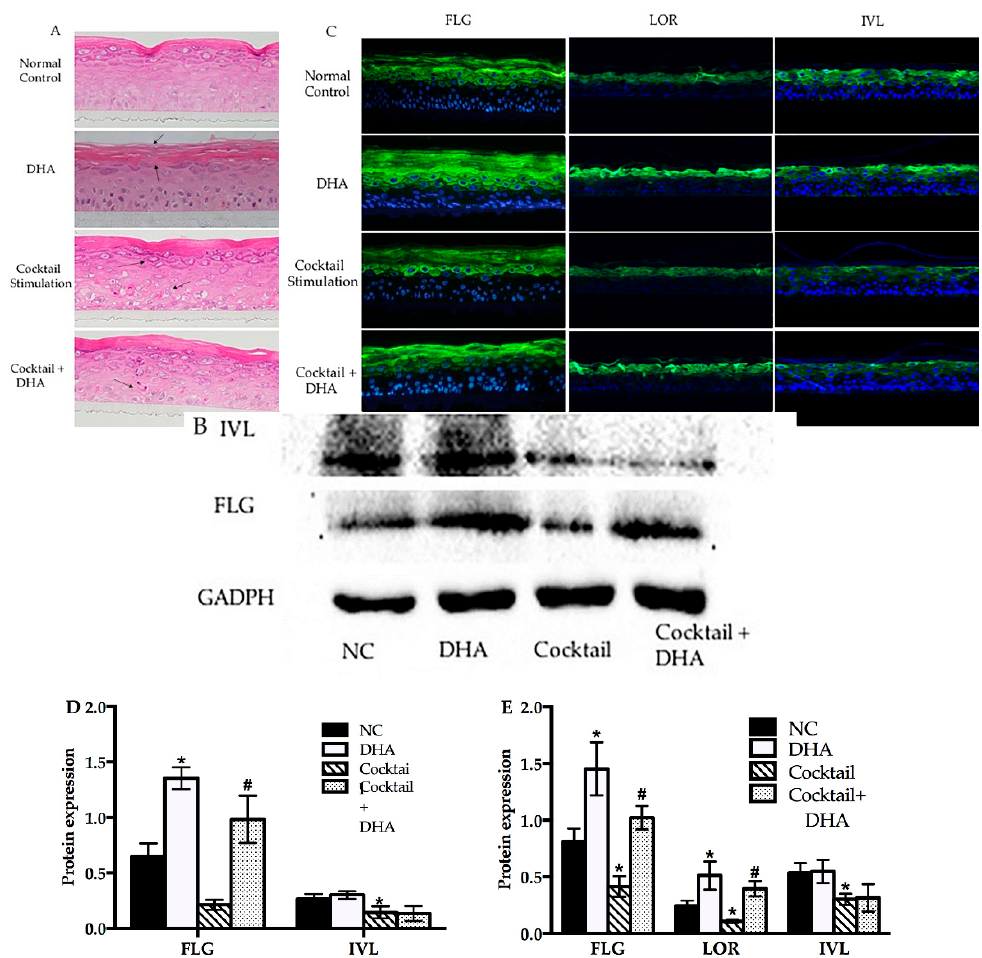
Figure 4. Topical treatment with DHA affected the morphology and differentiation protein expression in normal and inflammatory RHE models. ( A ) Morphology of normal, DHA cocktail-induced, and DHA-treated groups were evaluated using hematoxylin–eosin (HE) staining. ( B ) Western blot of FLG and IVL in normal control, DHA cocktail-induced, and DHA-treated groups. ( C ) Immunohistofluorescence analysis was executed for FLG, LOR, and IVL in the above RHE models. ( D ) Relative optical densities of FLG and IVL. ( E ) Relative fluorescence densities of FLG, IVL, and LOR. Magnification 10×, mean ± SD, n = 4–5. * Compared with the blank control groups, p < 0.05; # compared with the inflammatory group, p < 0.05. RHE, reconstructed human epidermis.